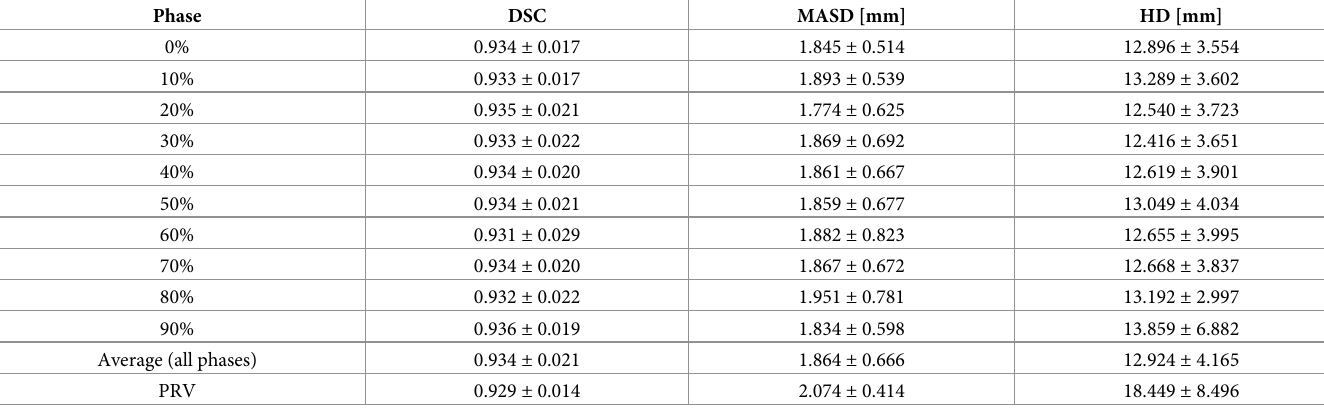
Table 2. Quantitative comparison of the automatic whole heart segmentation to manual contouring.